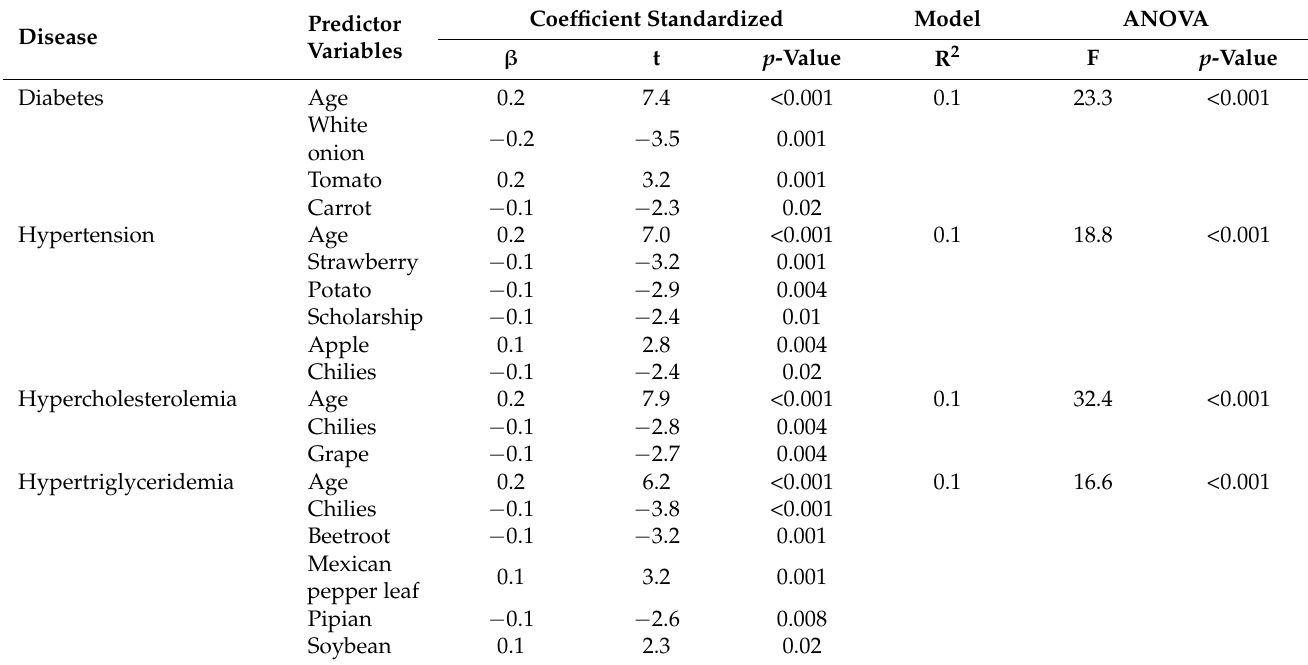
Table A3. Regression analyses of diseases and